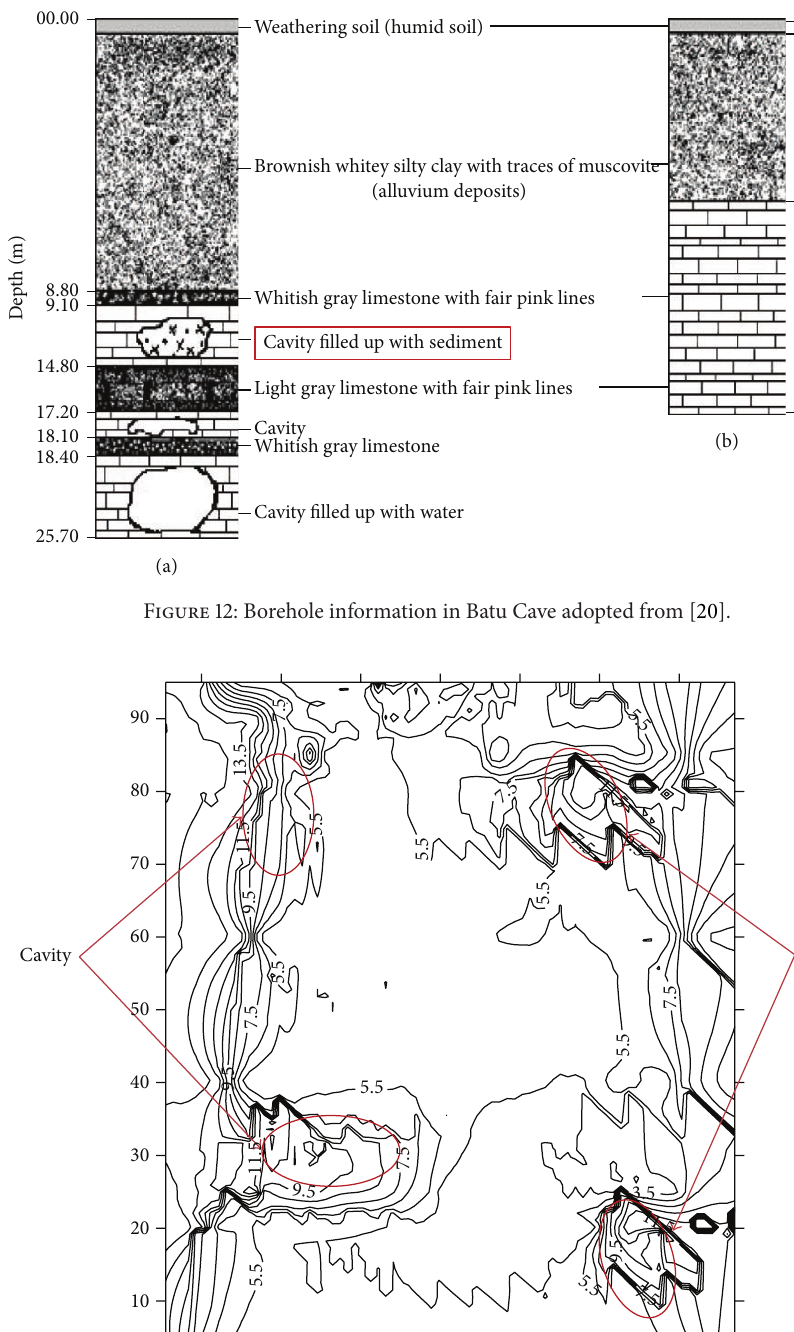
image of the same line, the porosity can be seen to range from 6% to 46%. The top part of the image is believed to be humid soil, which has porosity from 34% to 46%. This is followed by an alluvium layer with porosity ranging between 20%